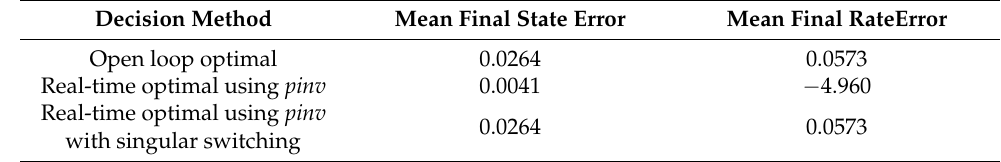
Figure 13. Comparison of the impacts of system variations on real-time optimal using ( a ) open loop optimal, ( b ) pinv without switching, ( c ) pinv with switching. Scaled state on the abscissae and scaled rate on the ordinates. Table 9. Impact of variations with real-time optimal decision methods using pinv inversion.